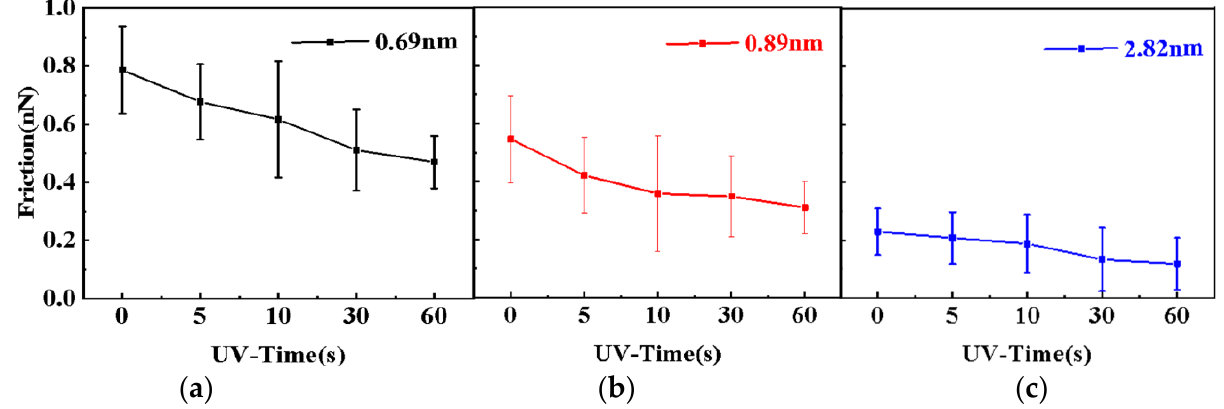
Figure 5. The relationship between friction force of graphene with different thicknesses and UV vacuum irradiation time: ( a ) 0.69 nm, ( b ) 0.89 nm, ( c ) 2.82 nm. vacuum irradiation time: ( a ) 0.69 nm, ( b ) 0.89 nm, ( c ) 2.82